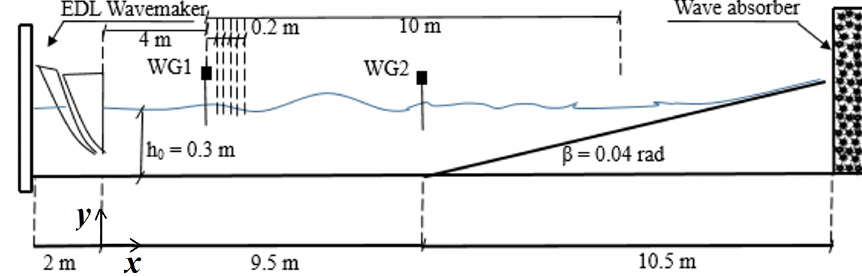
Figure 1. Schematic experimental set-up: WG1 and WG2 denote wave gauge no. 1 and wave gauge no. 2